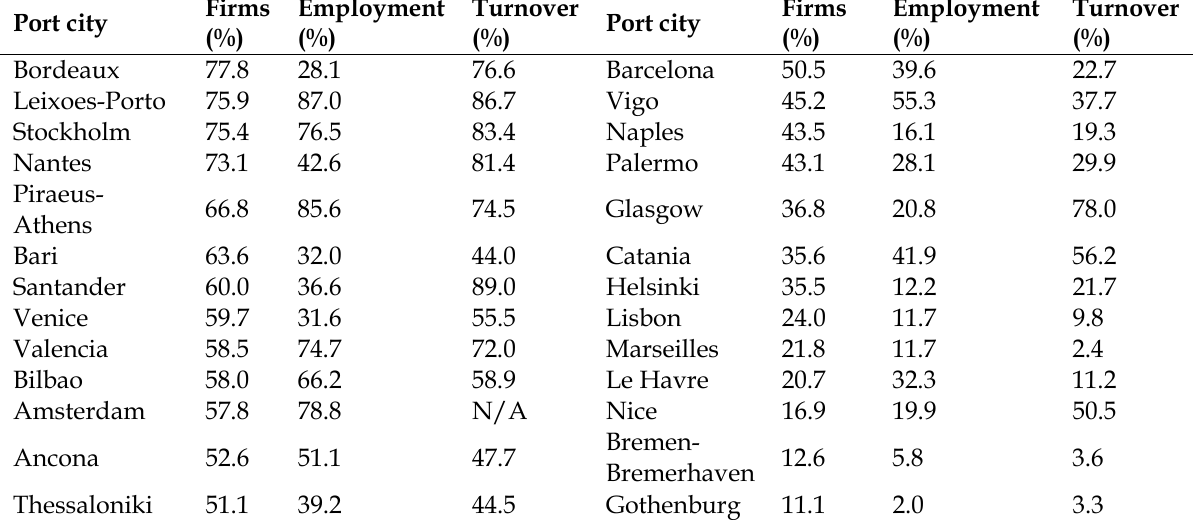
Table 2. Suburban concentration in selected port